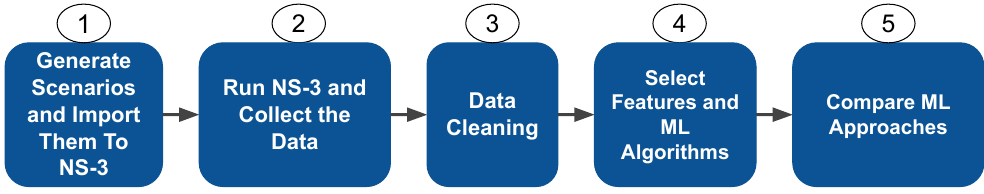
Figure 1. Workflow of the proposed